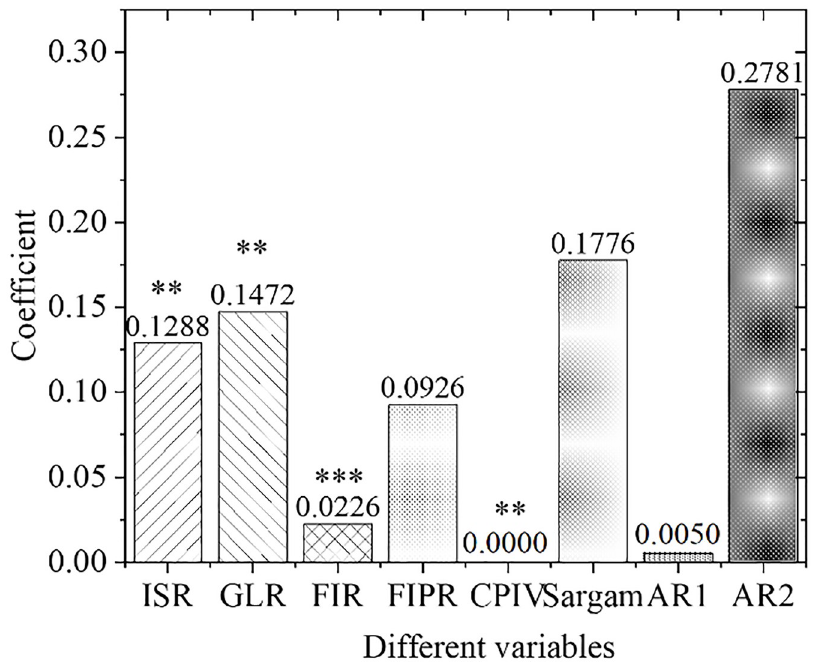
Fig 15. Robustness analysis results (empirical panel coefficient estimation in the eastern region).